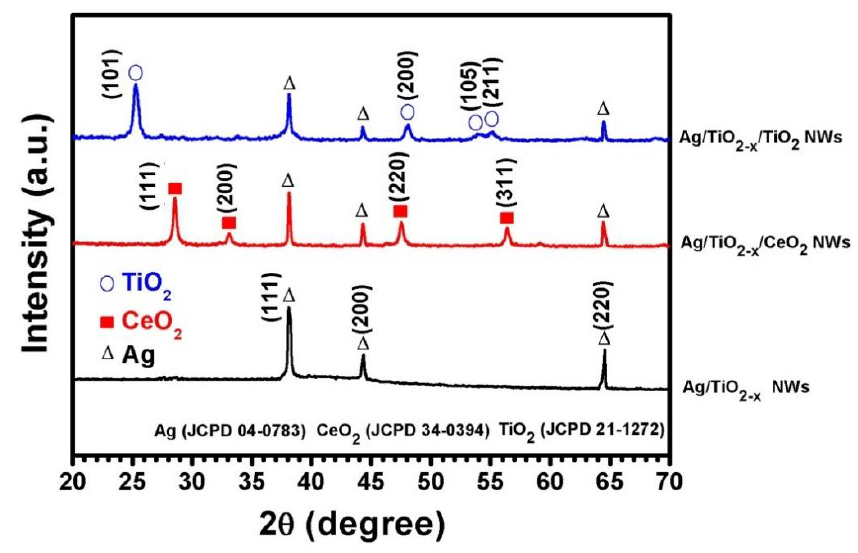
Figure 3. GIXRD patterns of the Ag / TiO 2 − x , Ag / TiO 2 − x / TiO 2 and Ag / TiO 2 − x / CeO 2 NWs (The shell thicknesses were 1 nm for TiO 2 − x , 5–7 nm for TiO 2 , and 4–6 nm for CeO 2 ).